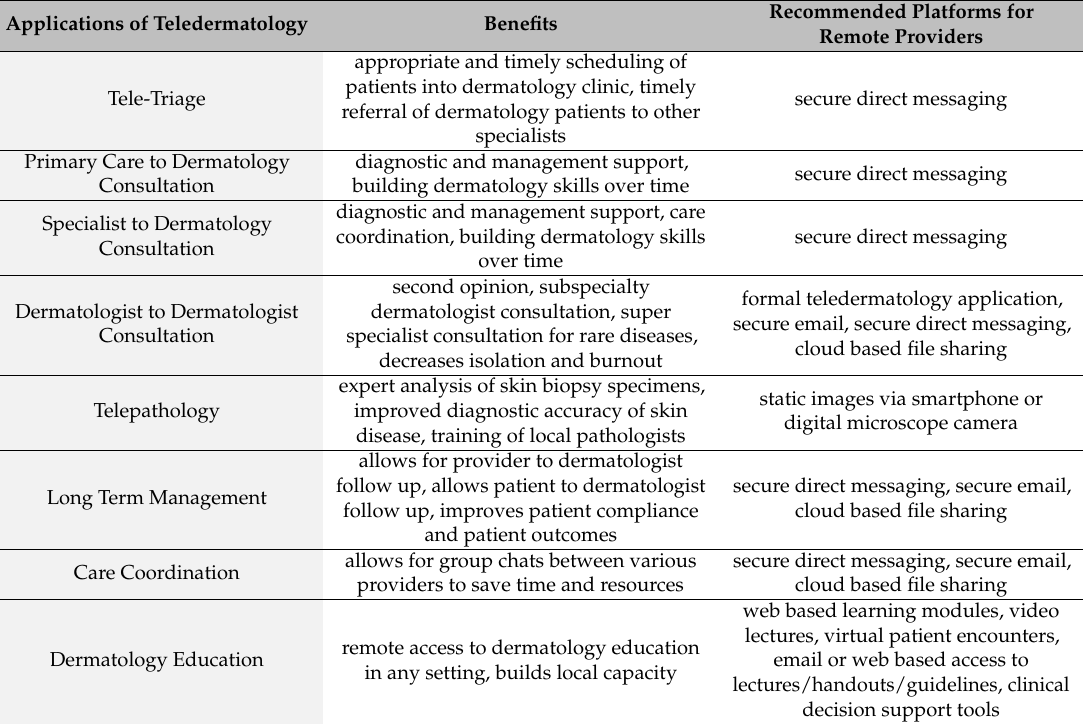
Table 2. Summary of the methods in which teledermatology can be utilized in practice, associated benefits and recommended platforms for remote providers in field